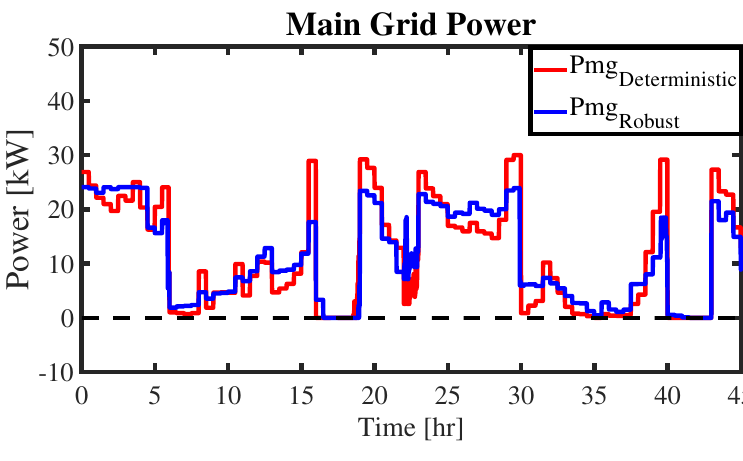
Figure 5. Main grid power